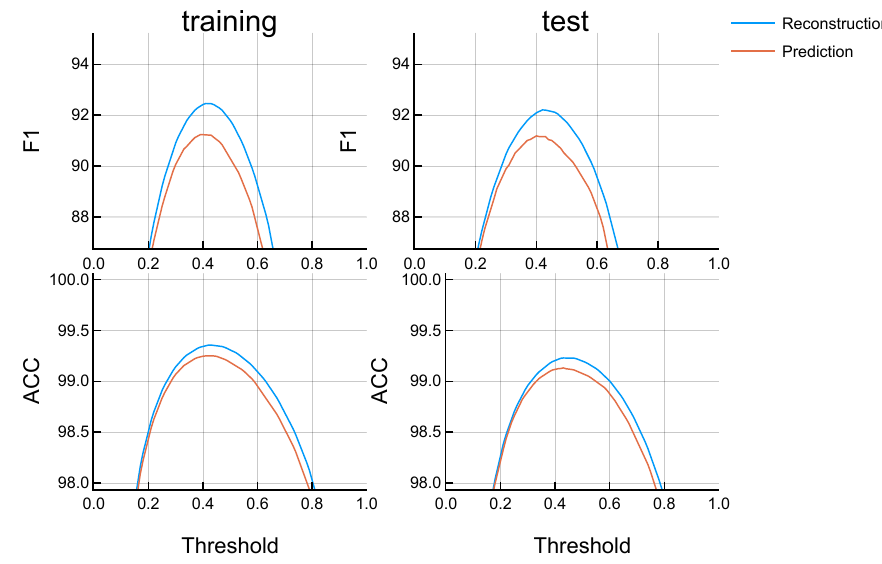
Figure 3. Comparison of the results in the reconstruction and prediction problems.